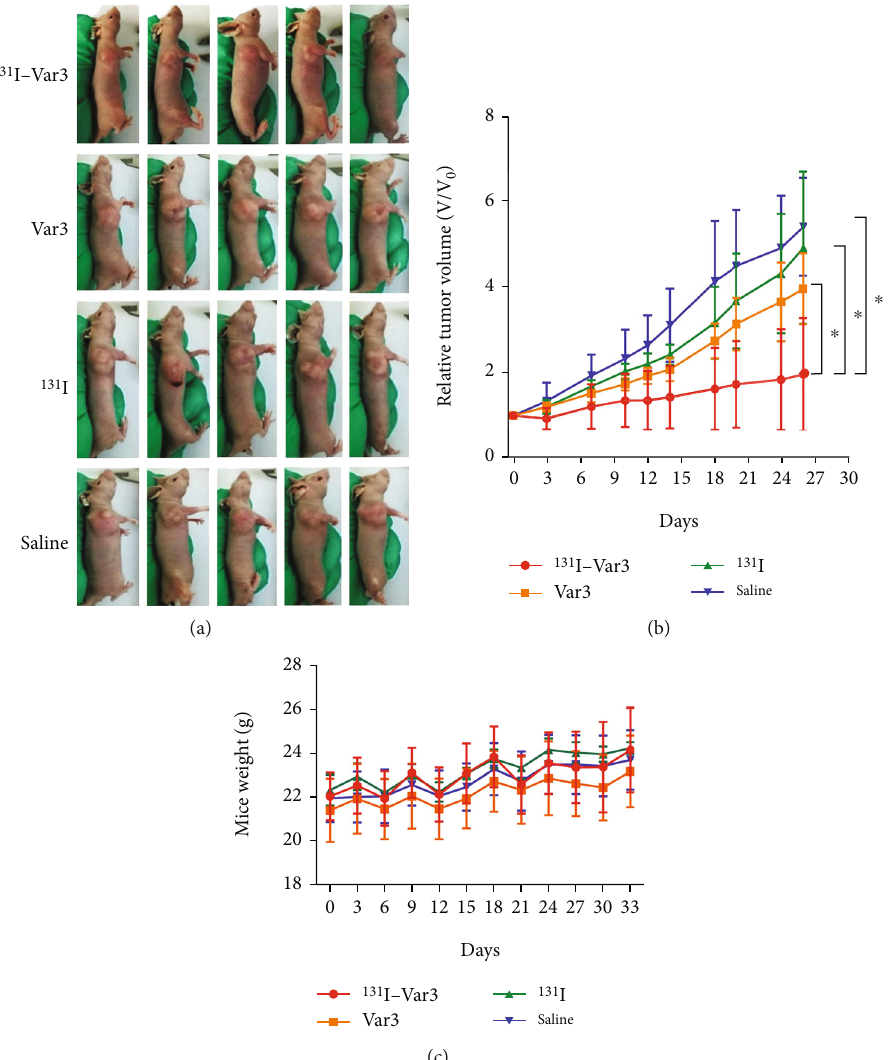
Figure 5: Therapeutic e ffi cacy of 131 I-labeled variant 3 pH-low insertion peptide (Var3-pHLIP) in mice-bearing MDA-MB-231 xenografts. (a) Images of MDA-MB-231 xenografts in the four study groups ( n = 5 for each group) at the end of treatment. (b) The relative tumor volume in MDA-MB-231 xenografts was signi fi cantly lower in the 131 I-Var3-pHLIP-treated group ( 2 : 06 ± 0 : 47 ) than in the groups treated with Var3-pHLIP ( 4 : 17 ± 0 : 51 , p = 0 : 027 ), 131 I ( 5 : 14 ± 1 : 51 , p = 0 : 001 ), and saline ( 5 : 43 ± 1 : 15 , p < 0 : 001 ) at the end of treatment. The asterisk indicates that p value is less than 0.05. (c) There was no signi fi cant di ff erence in body weight among the groups. Data are means ± SD